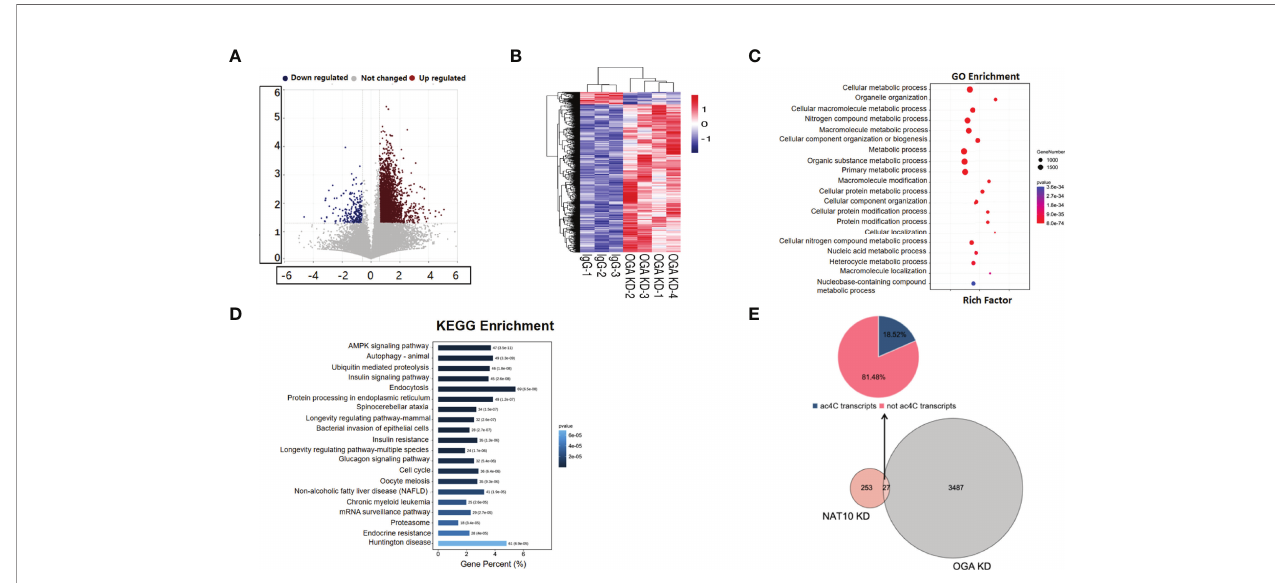
FIGURE 5 | Expression Pro fi ling of Oocytes with OGA Knockdown. (A) Volcano map showed global genes change after OGA KD, with blue dots representing downregulation and red dots representing upregulation. (B) Heatmap showed the overall clusters of differential expression of genes. (C) A total of 3,514 DEGs with OGA KD were mainly associated with metabolic processes according to GO enrichment. (D) KEGG analysis displayed top 20 pathways where 3,514 DEGs were involved in. (E) Pie chart showed the distribution of DEGs by joint analysis of OGA KD, NAT10-KD transcriptomes, and ac4C RIP